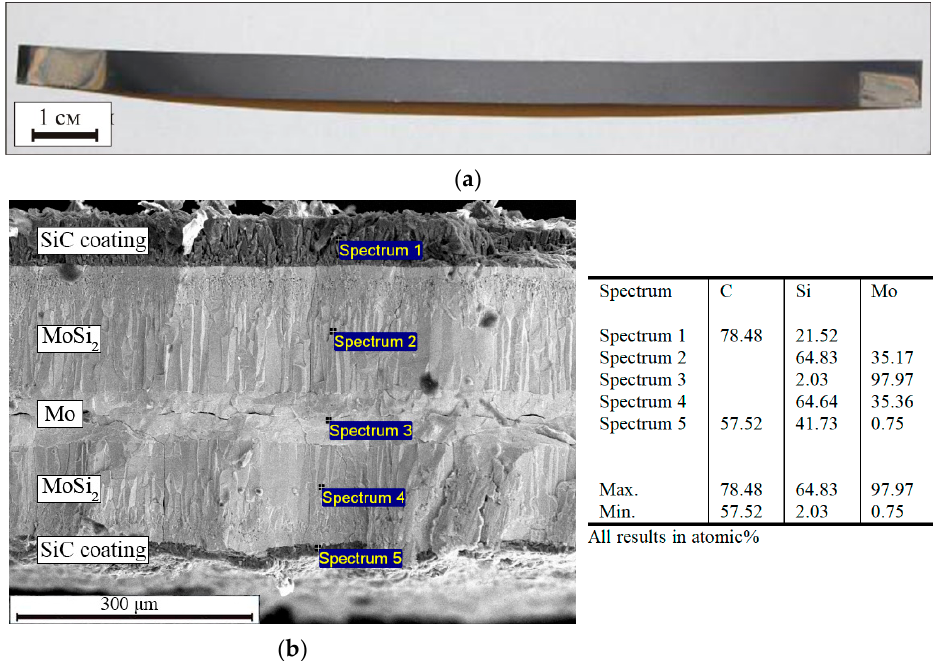
Figure 17. Protective gas-tight SiC coating on a molybdenum heating element ( a ). Phase analysis of the heating element’s cross section ( b ).